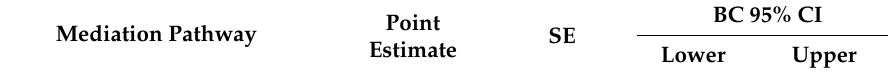
Table 5. Results of multiple mediation analysis of the relation between sociotropy and autonomy, respectively, and anxiety symptoms in patients with GAD ( n =